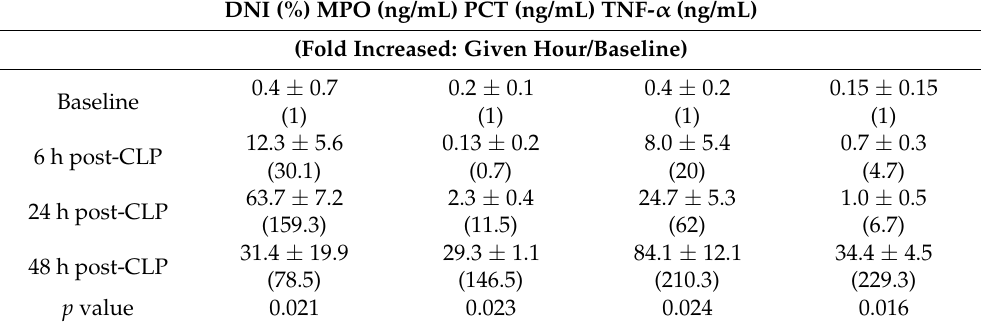
Figure 1. Kaplan–Meier curve in CLP-induced sepsis mice following different CLP timing. To confirm the validity of our CLP-induced sepsis as well as the optimal time to predict the severity of sepsis by measuring biomarkers level, we examined the lethality [[the dead number (percentage: %)]] of CLP-induced septic mouse at 6 h, 24 h, and 48 h post-CLP. It was 4 (19%) out of 21, 11 (30.5%) out of 36, and 11 (39.2%) out of 28 (Table 1). Log-rank test between each group was significant ( p = 0.0018). Table 2. Comparative level of DNI, MPO, PCT, and TNF- α in sepsis mice following the duration of post-CLP.